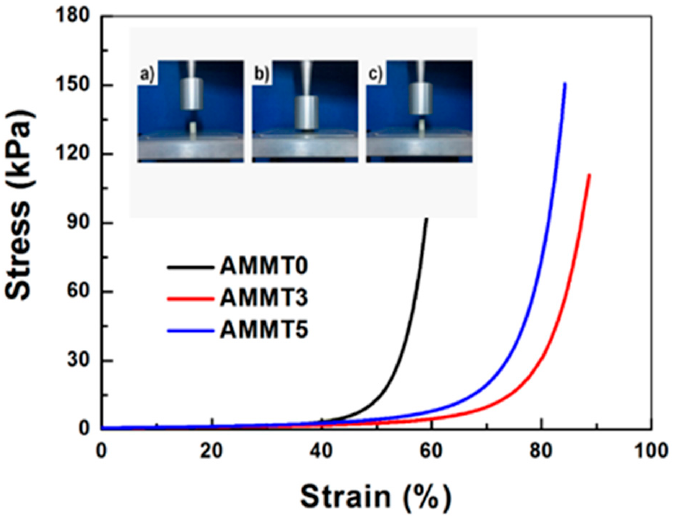
Figure 6. Typical stress–strain curve for AMMT0, AMMT3, and AMMT5 cryogels. (Inset: Digital images of AMMT3 ( a ) before, ( b ) during, and ( c ) after uniaxial compression test).